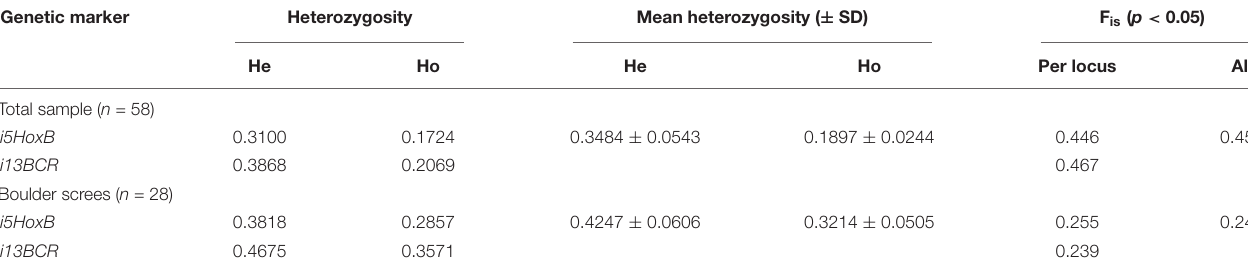
TABLE 3 | Population genetic characteristics of the mixed marmot population of the Ulagchin-Gol valley. Genetic marker Heterozygosity Mean heterozygosity ( ± SD) F is ( p < 0.05) Ho Ho Per locus